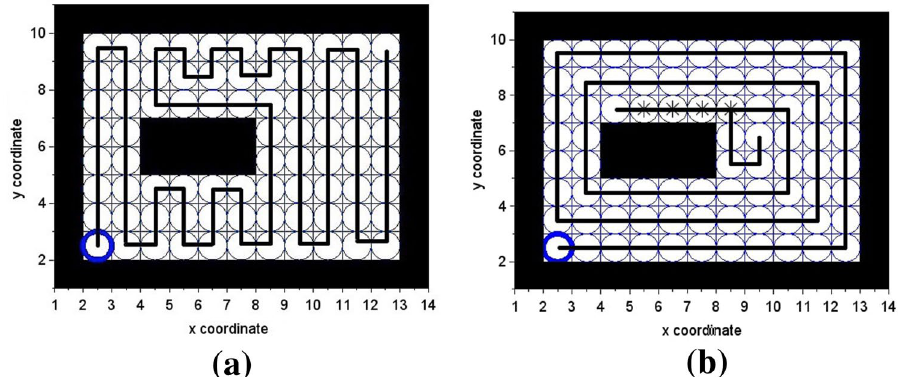
Fig. 12 Comparison with Luo’s algorithm with a single robot: a Luo’s algorithm [1], b proposed